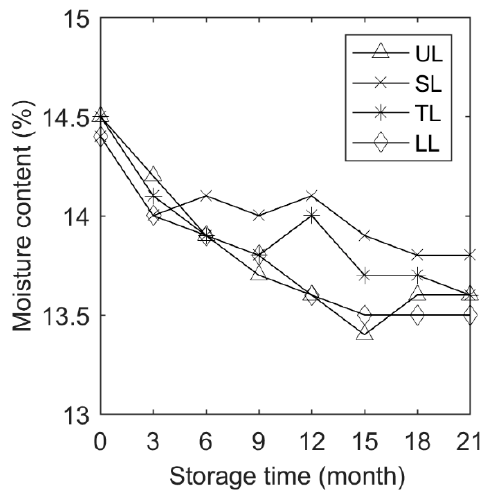
Figure 5. Moisture content changes of grain during storage. The value of each point is the average of the 18 positions in the layer.